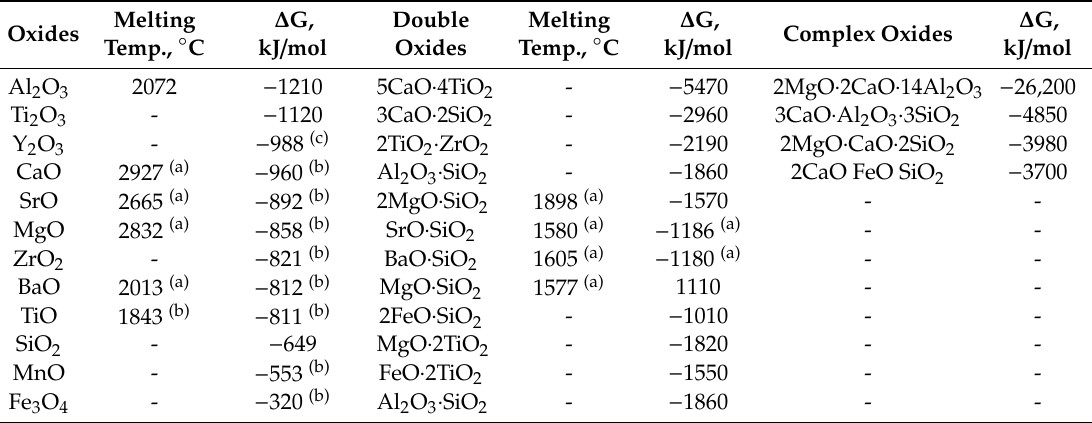
Table 2. Melting points and standard free energy of formation of selected